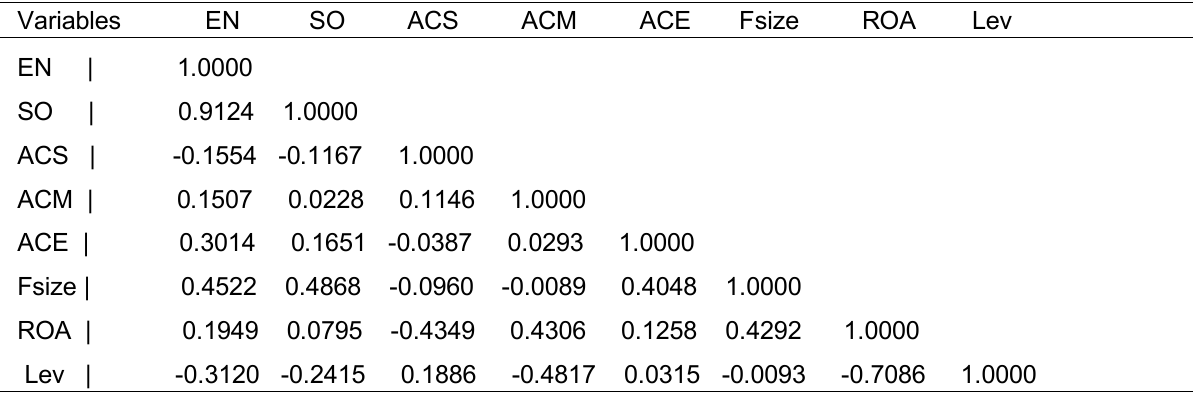
Table 1: Pearson correlation